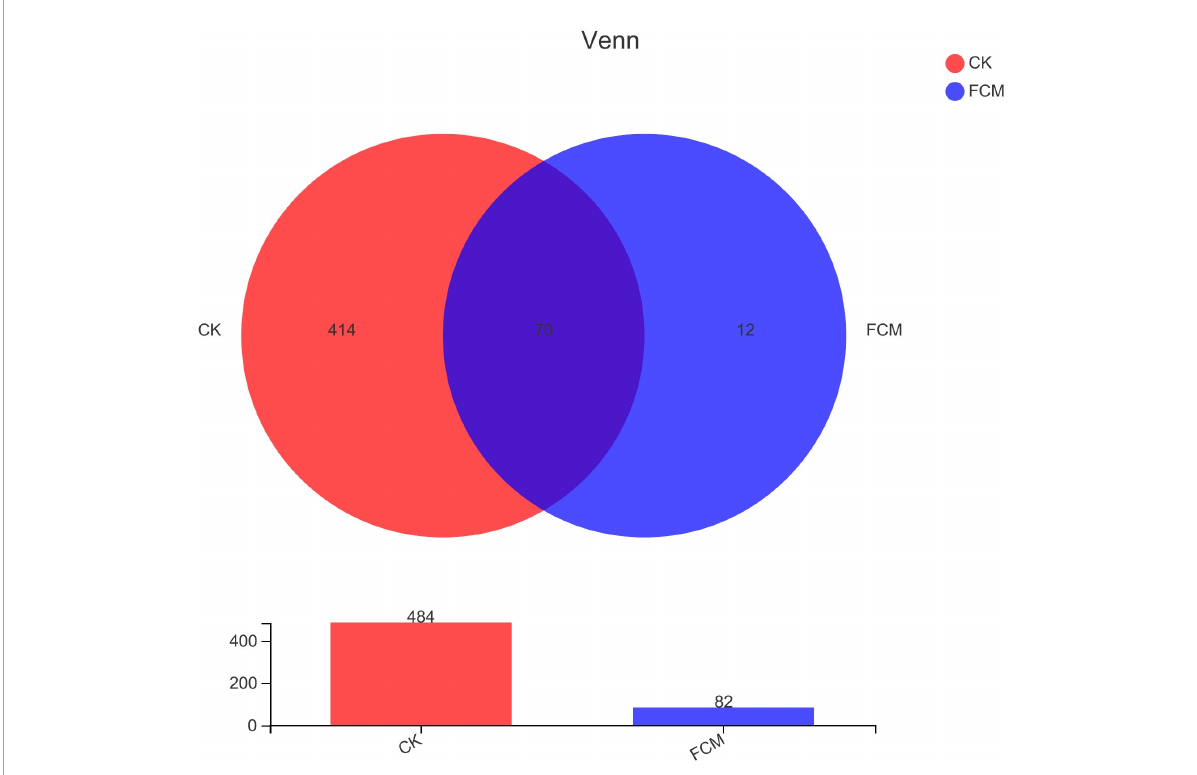
FIGURE6 Venn diagram analysis based on operational taxonomic units (OTUs) for different groups. The number of overlapping parts is the number of OTUs shared between the two samples [CK: cottonseed meal (CM); fermented cottonseed meal (FCM):